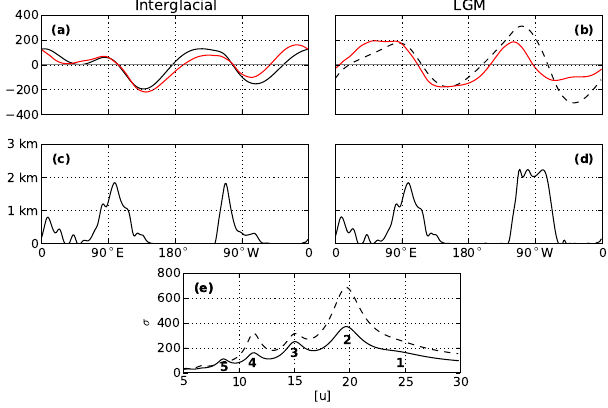
Figure 9. The top panels (a, b) show a comparison of the midtro- pospheric eddy geopotential (m) at 45 ◦ N computed by the linear barotropic model (black) and the atmospheric circulation model (red) at 500hPa. The panels on the left show the interglacial and the panels on the right the fields from the LGM simulations. The corresponding topographic profiles are shown in the middle pan- els (c, d) . In the lower panel (e) we show the standard deviation q [ ψ 2 ] ) as a function of of the geopotential height response (σ = 0 the zonal mean wind [ u ] . Here we use a more generous damping timescale of r − 1 = 20days for display purposes. One can clearly see how different wave numbers resonate at certain wind speeds. The solid line uses the present day topography (c) and the dashed line the LGM topography (d)